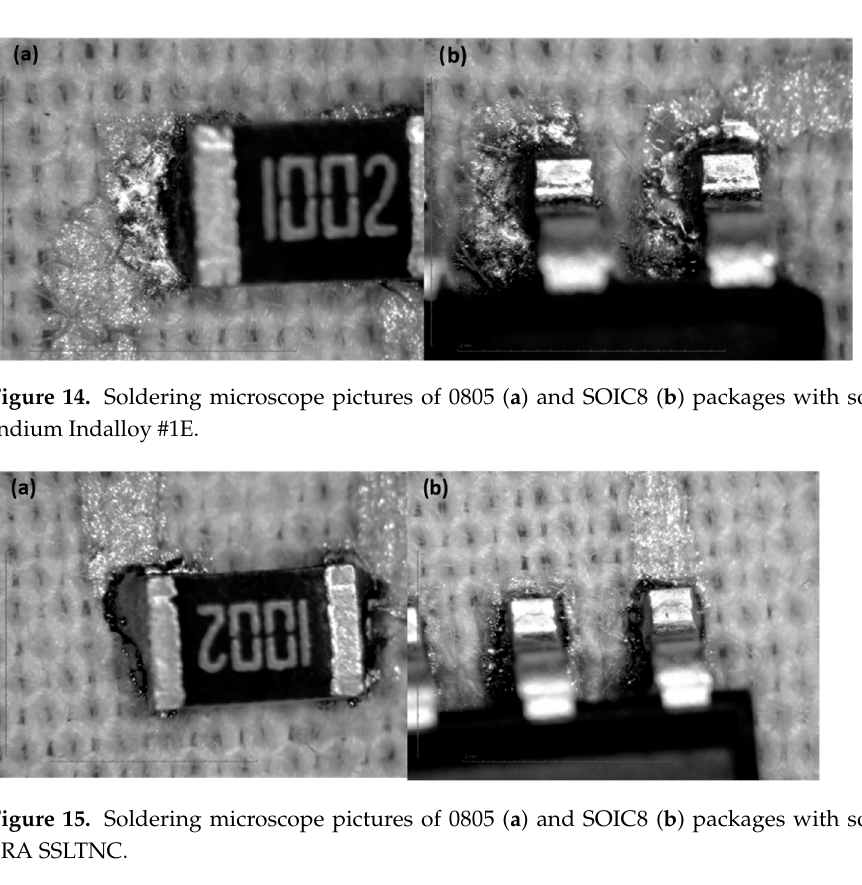
Figure 13. Soldering microscope pictures of 0805 ( a ) and SOIC8 ( b ) packages with solder paste In ‐ dium Indalloy #281.